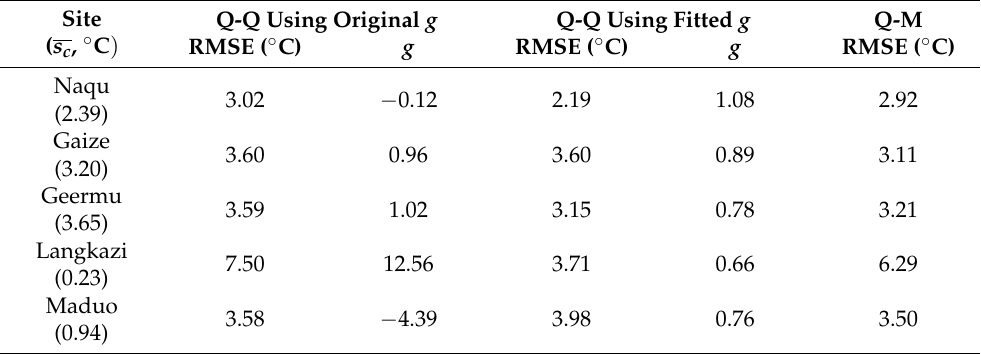
Table 6. Comparison in adjusting air temperature by using fitted values of the g parameter over the original form of g (Equation (5)) in terms of RMSE at five representative sites. The control and projection periods correspond to 1970–1984 and 1985–1999, respectively. The GCM MPI is used. s c is the average air temperature in the control period on the site. Q-M stands for the quantile mapping